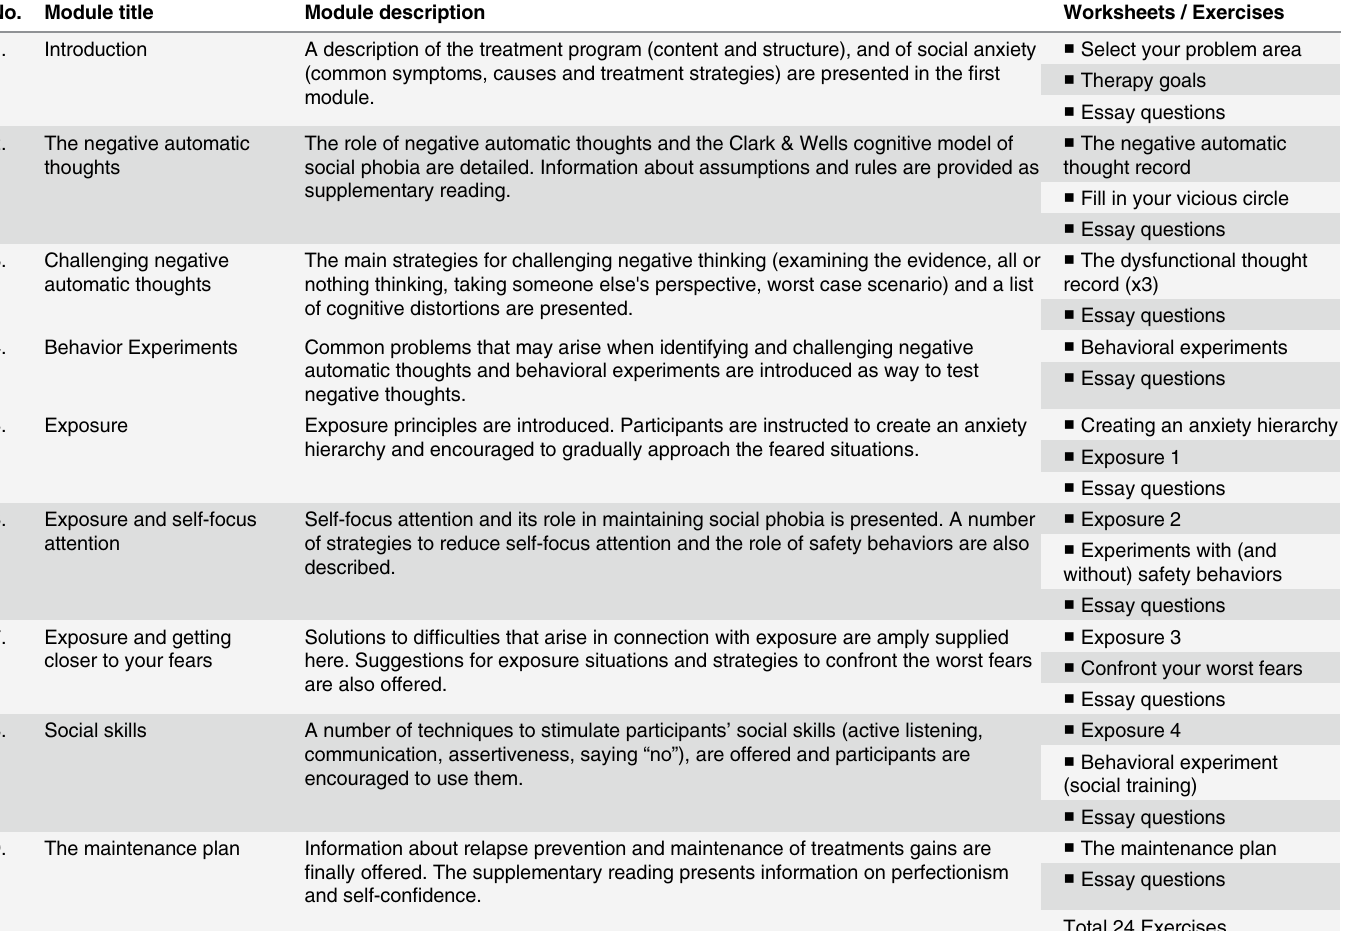
Table 2. Brief Description of the Romanian iSOFIE intervention